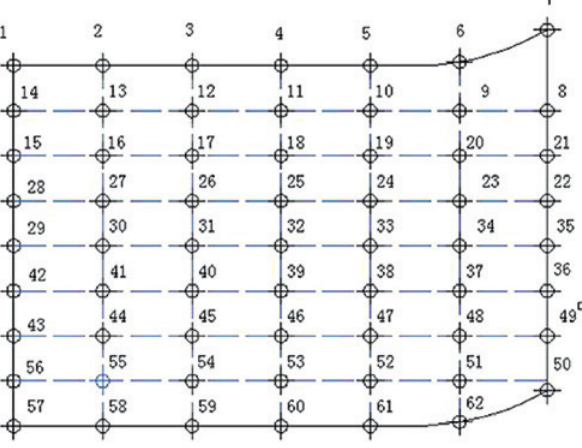
Figure 6: The distribution of data points.